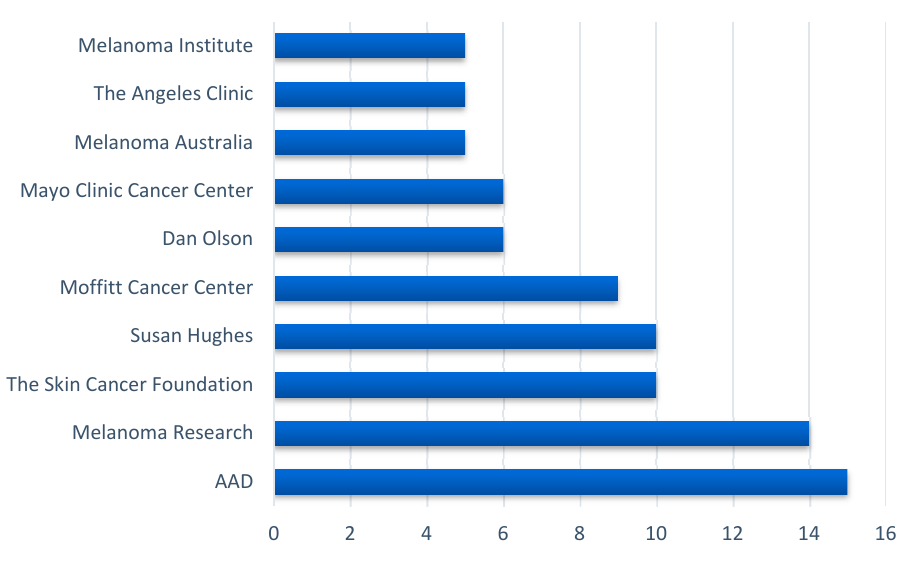
Figure 3. Top sources of melanoma-related information on Twitter ranked by the in-degree centrality